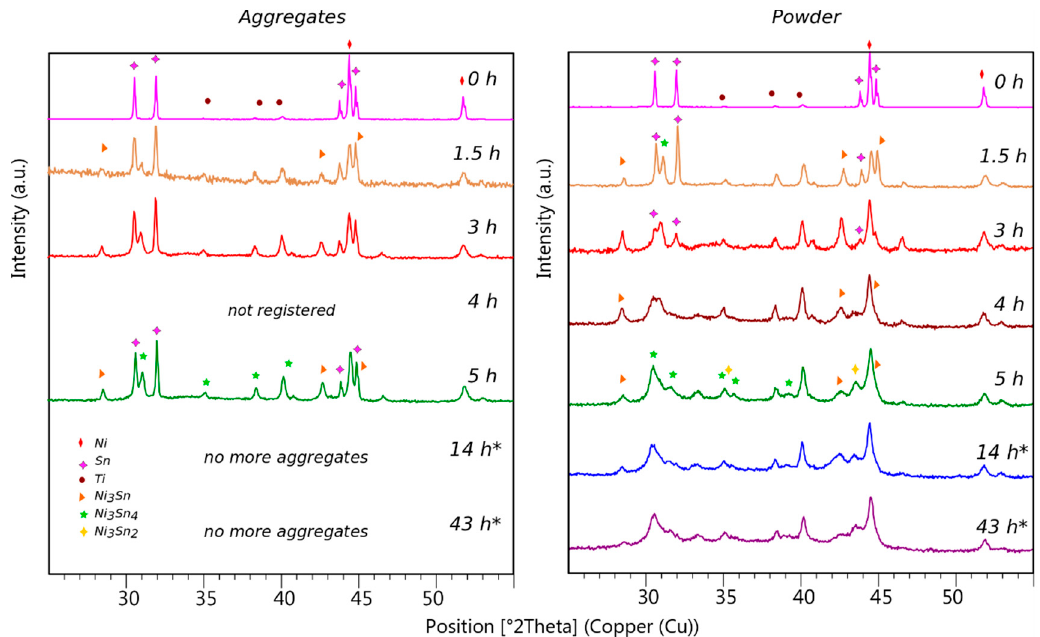
Figure 6. XRD patterns for the powder and the aggregates collected in samples alloyed at 400 rpm. It is important to note that no aggregates are found after long reaction times (14–43 h*).